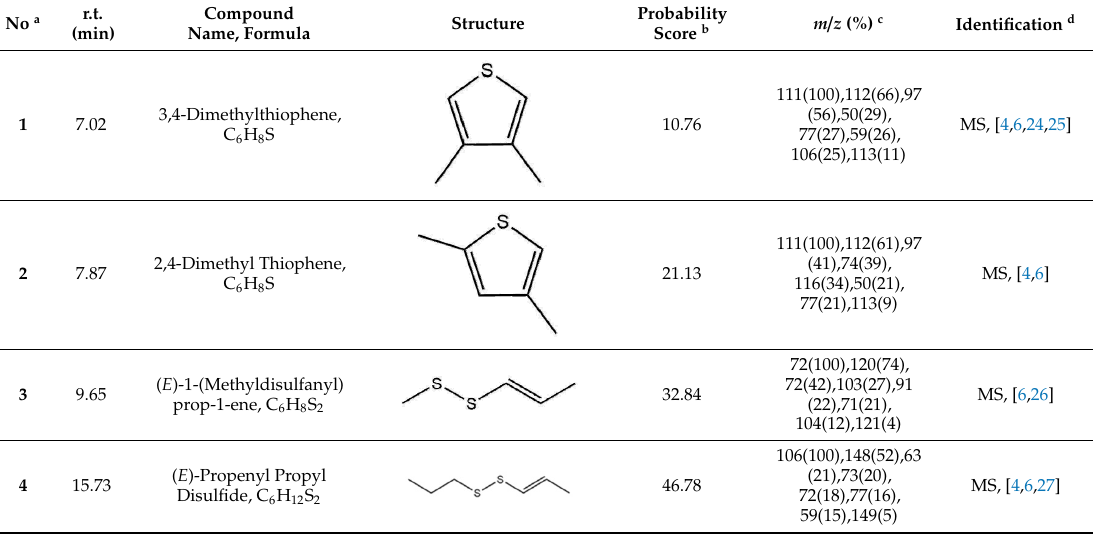
Figure 1. Chromatograms of organosulfides extracted from steam distilled onion oil using ( a ) dichloromethand (DCM), ( b ) diethylether (DEE), ( c ) n-pentane, and ( d ) hexanes. Chromatogram peak numbers correspond to sample number in Tables 1 and 2. Table 1. Predicted organosulfide structures and probability scores.